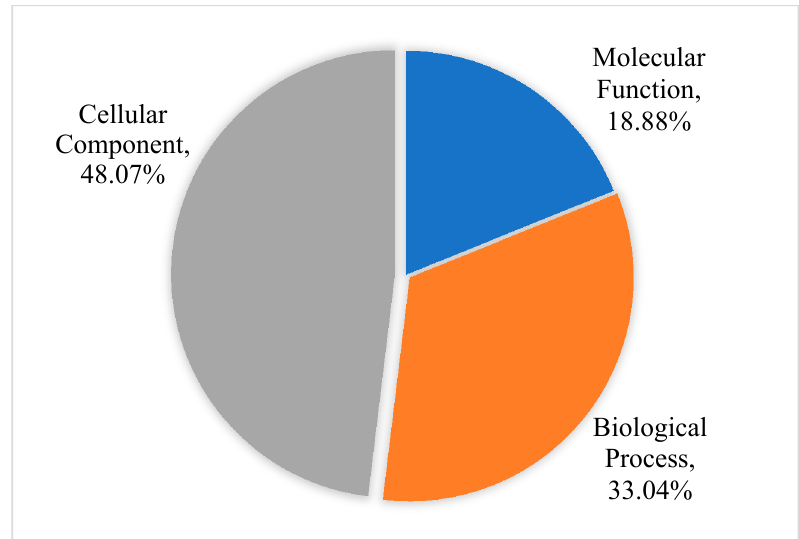
Figure 1. The functional analysis of increased and decreased abundance proteins in the membrane versus cytosolic fractions.